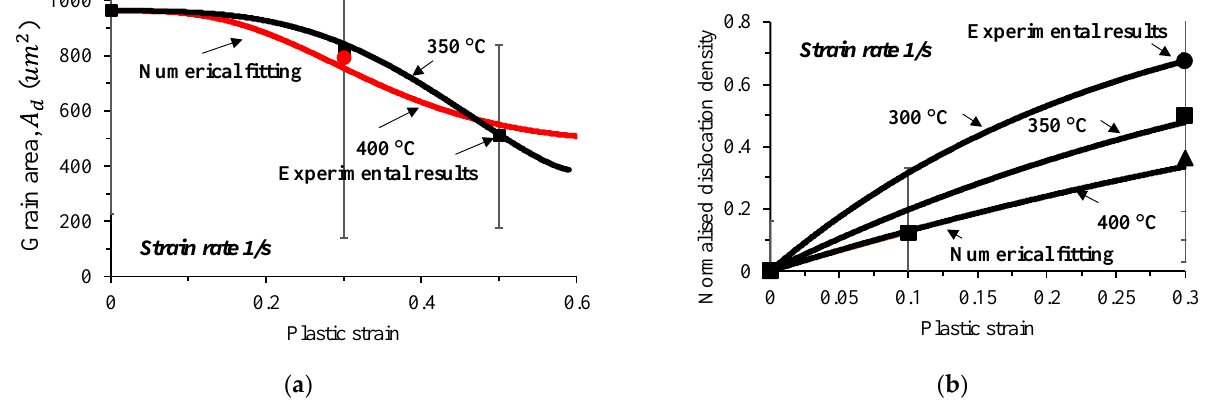
Figure 6. Comparisons between experimental and CDM model computed results at various deformation temperatures with a strain rate of 1/s: ( a ) average grain area evolution, and ( b ) normalized dislocation evolutions. Solid symbols represent experimental results and solid lines represent numerical fittings. Table 4. The determined material constants for the dislocation mechanics-dominant